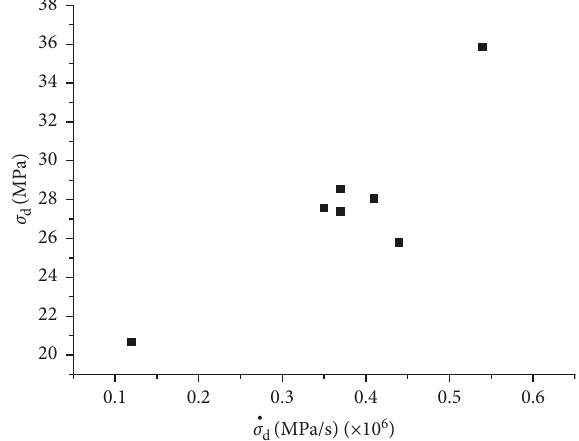
Figure 10: Relationship between dynamic tension strength and loading rate at depth 530m.